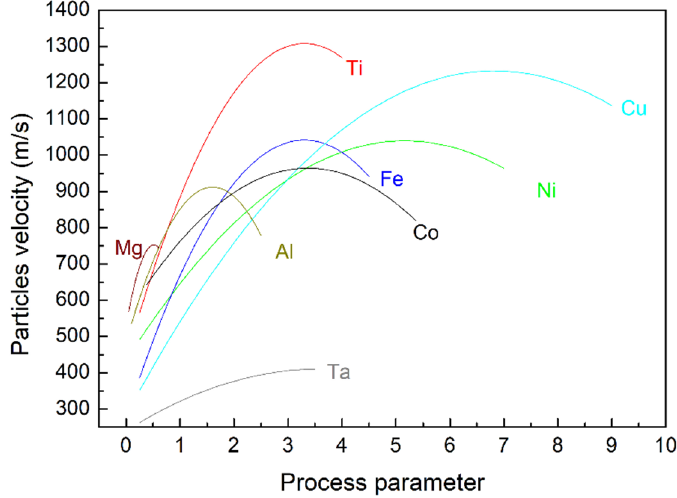
Figure 4. Particle impact velocity as a function of the process parameter for all the studied alloys